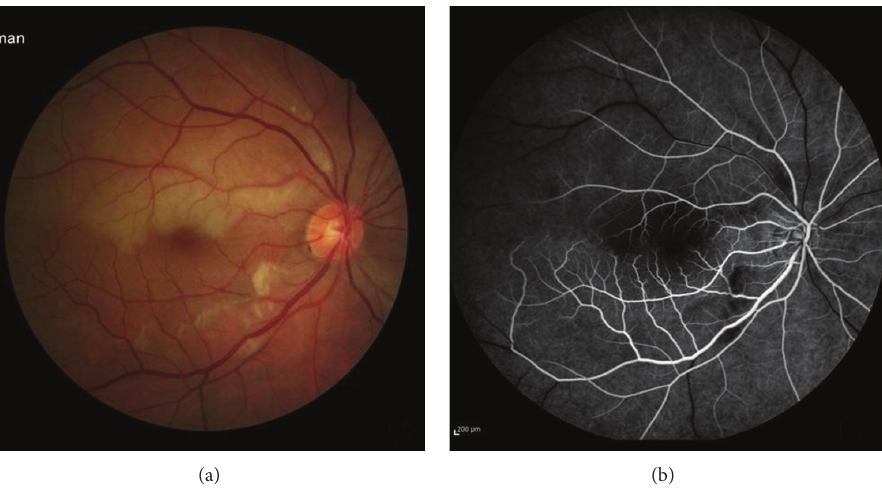
Figure 1: (a) Fundus photograph of the right eye with superior hemiretinal edema due to superotemporal branch retinal artery occlusion. (b) Fluorescein angiogram of the right eye revealed the presence of delayed filling of the superotemporal branch retinal artery.